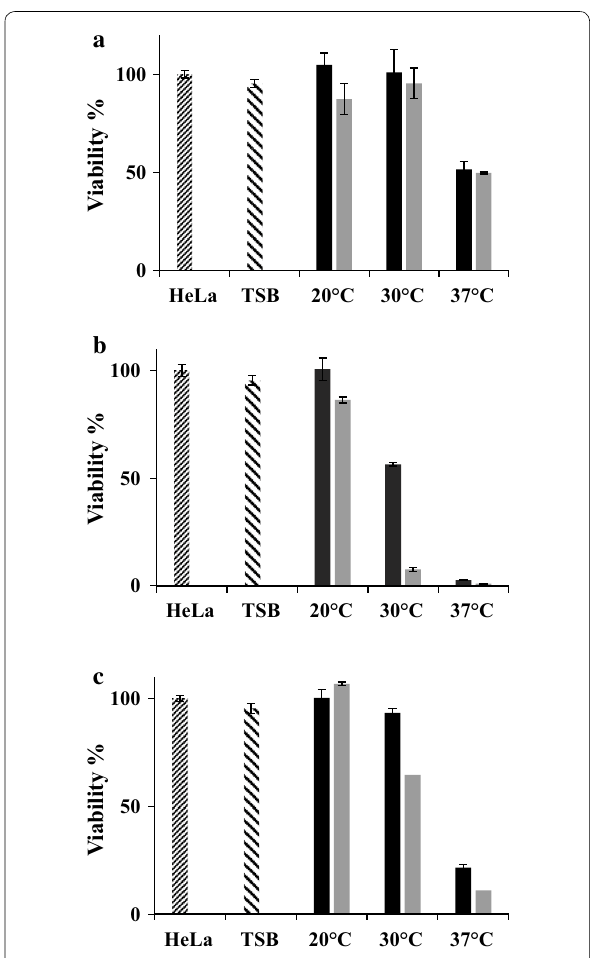
Fig. 5 Cytotoxicity of Staphylococcus aureus supernatants recovered from planktonic and biofilm cultures. Cell cultures were grown at 20, 30 and 37 °C, during 24 h (black square) and 48 h (grey square). Planktonic cells ( a ), biofilms grown on polycarbonate ( b ) and biofilms grown on stainless steel ( c